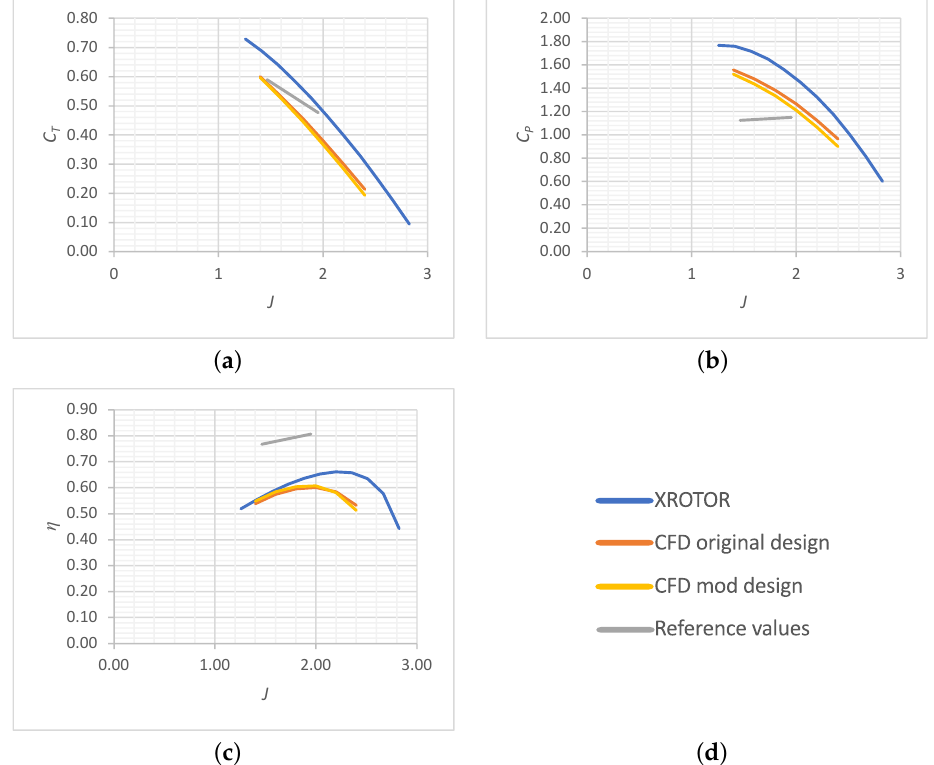
Figure 6. Propeller analysis, comparison between XROTOR and CFD results: ( a ) thrust coefficient; ( b ) power coefficient; ( c ) propeller efficiency; ( d )